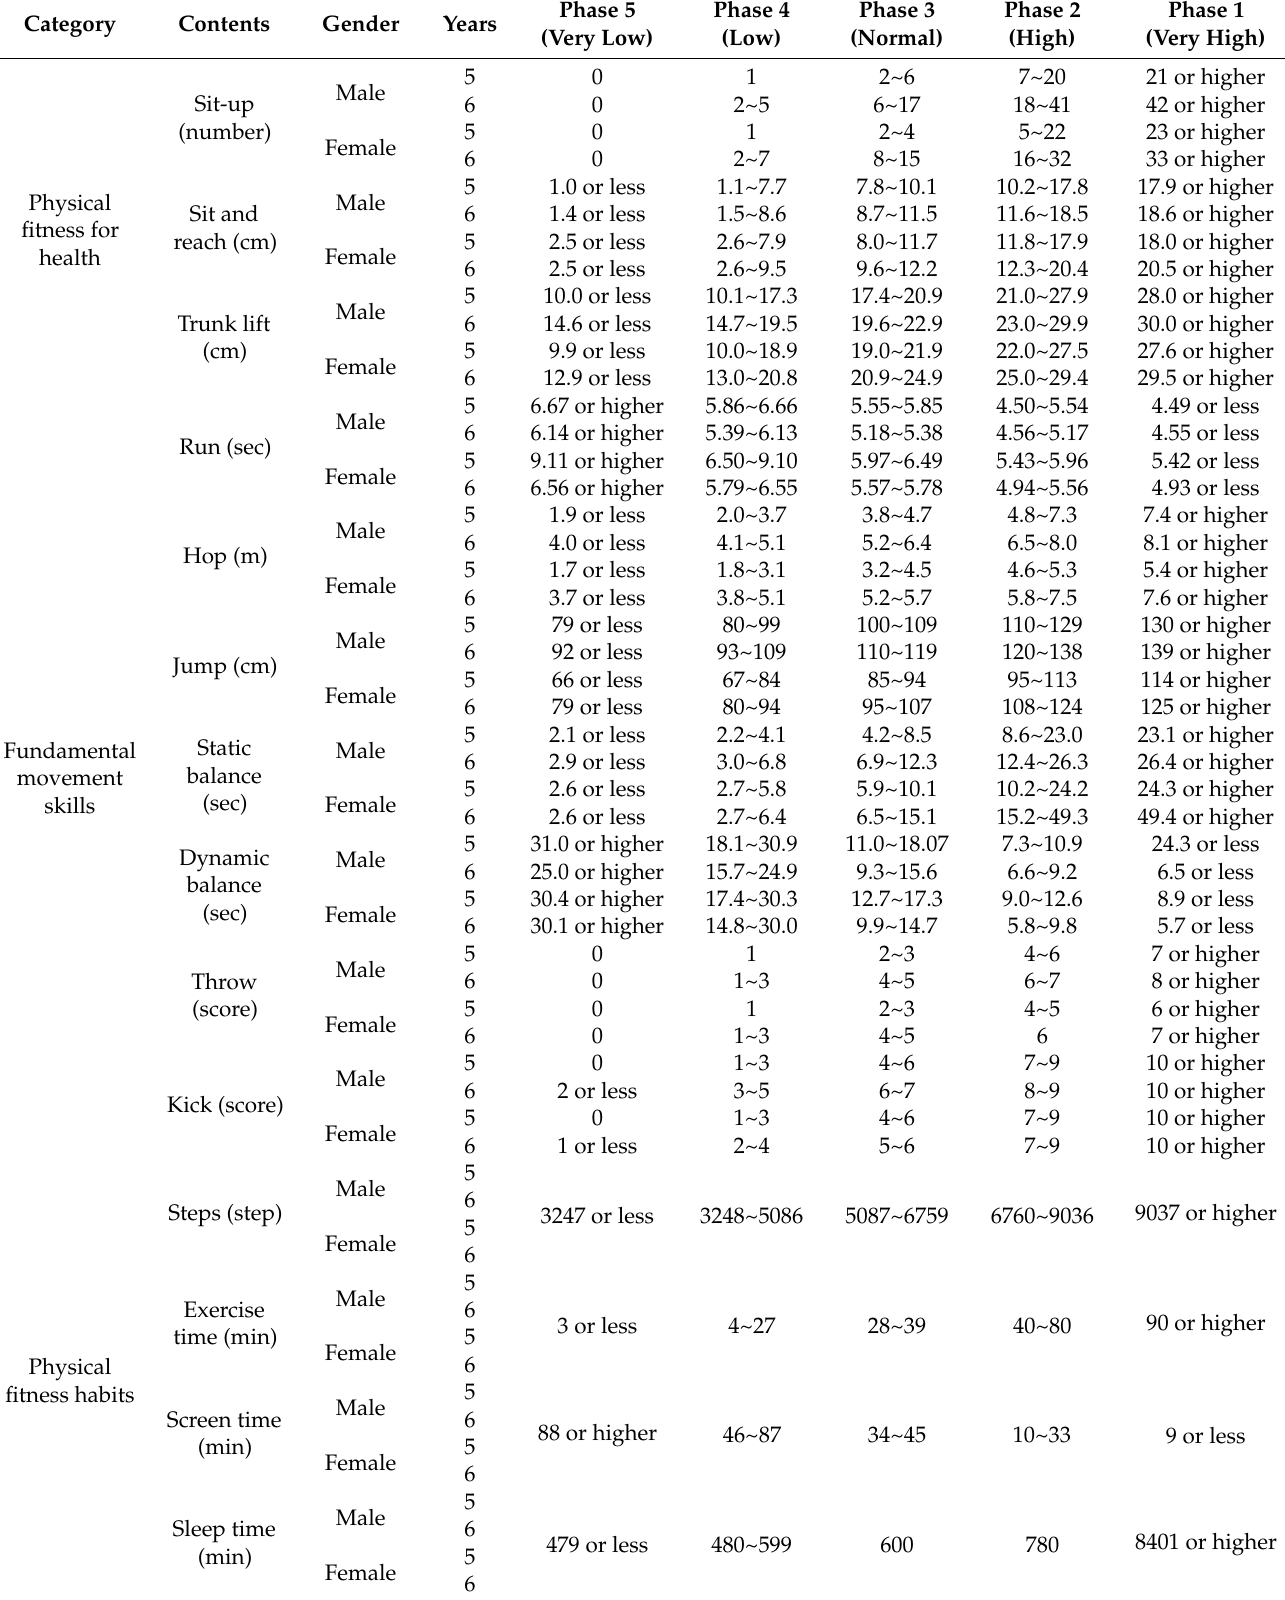
Table A1. Physical Activity Competence Evaluation